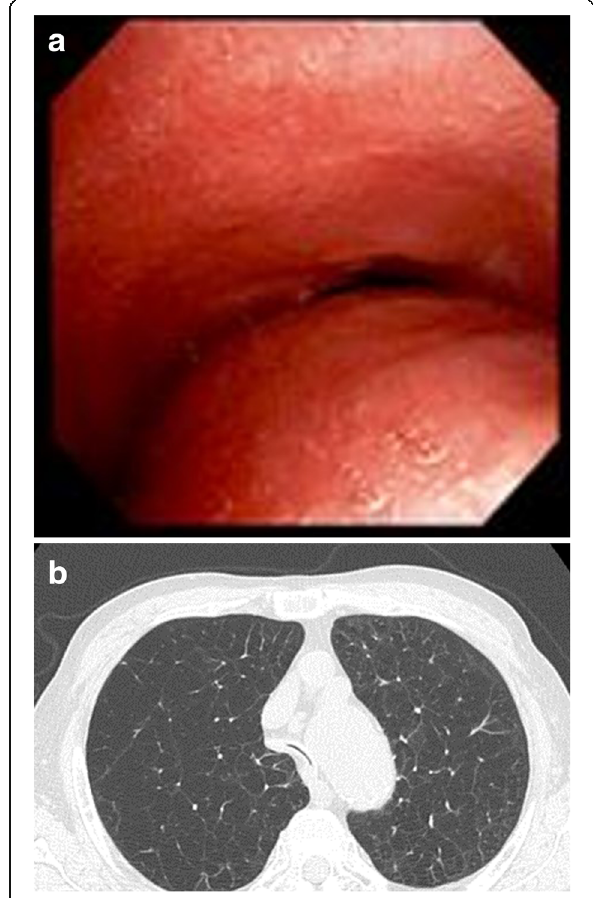
Fig. 1 Bronchoscopy and chest computed tomography (CT). a . Bronchoscopic examination showing occlusion during coughing. b Chest CT revealing stenosis ranging from the trachea to the right main